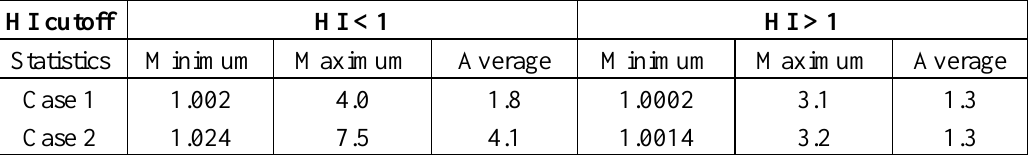
Table 5. Comparison of MCR values of samples with HI greater or less than